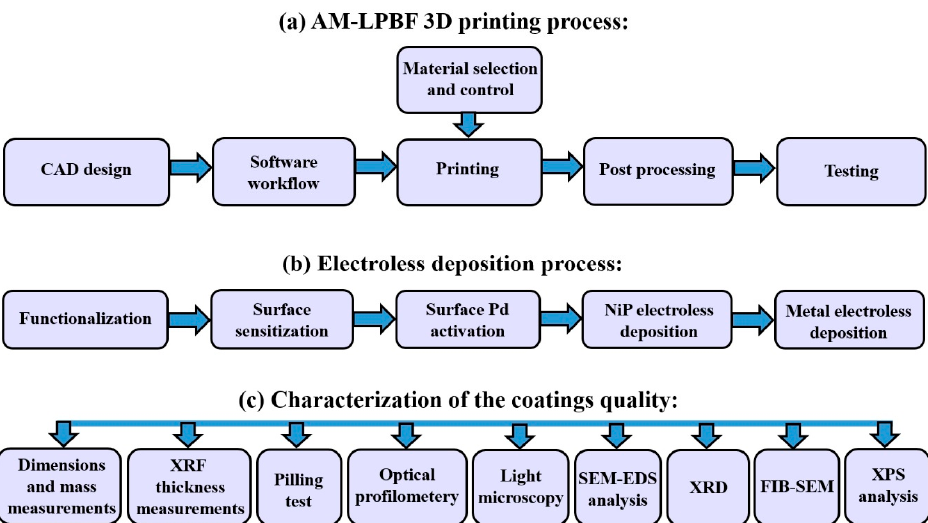
Figure 18. A schematic illustration of a suggested methodology for effective Au, Ag, and Au-Ag electroless deposition (ELD) coatings of AM-LPBF AlSi10Mg parts: ( a ) the AM-LPBF process, post-processing, and quality control; ( b ) the ELD process steps; and ( c ) recommended characterization methods for the analysis of the Au, Ag, and Au-Ag ELD films.